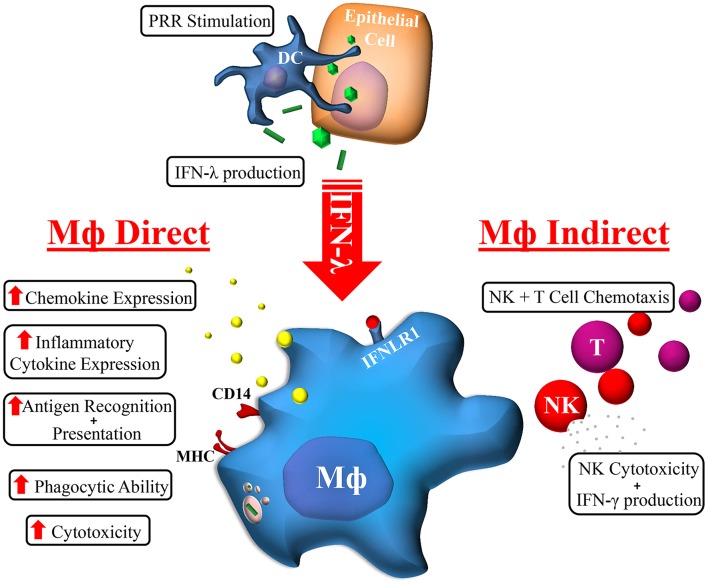
Macrophage orchestration of the IFN-λ immune response. In response to TLR stimulation by viral, bacterial, or fungal pathogens, IFN-λ produced by epithelial (e.g., hepatocytes) or immune cells (e.g., DC) can stimulate the expression of hundreds of Mϕ ISGs. The subsequent effects of IFN-λ on Mϕs can be categorized into direct and indirect effects: Mϕs cytotoxicity and phagocytic ability is increased, as is antigen recognition and presentation, and cytokine/chemokine secretion. Subsequent indirect effects include NK and T cell chemotaxis and increased NK cell cytotoxicity and IFN-γ production.